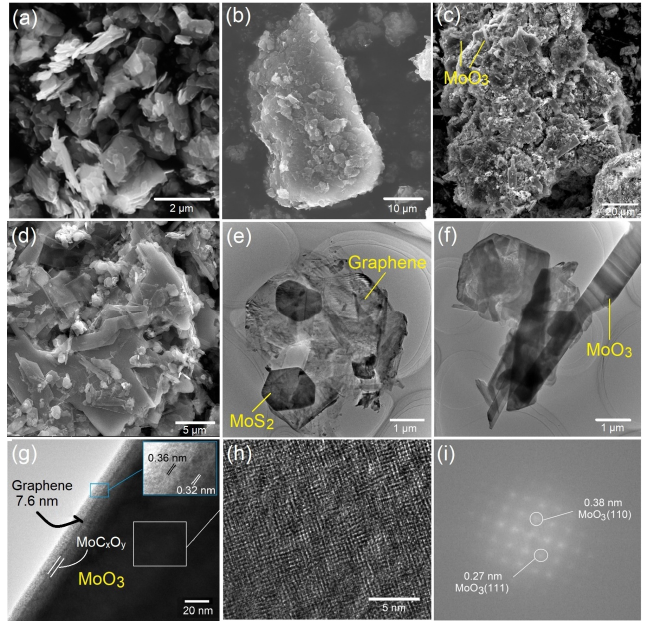
Figure 4. SEM micrographs of ( a ) commercial MoS 2 , ( b ) natural graphite, and ( c , d ) MoO 3 /MoS 2 @G ‐ 1100. ( e – h ) TEM micrographs of MoO 3 /MoS 2 @G ‐ 1100. ( i ) FFT pattern recorded on the micrograph ( h ).